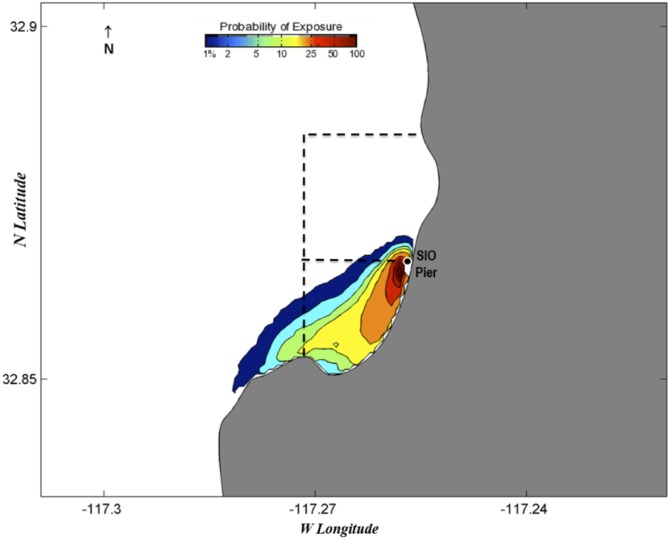
Probability map of predicted fish egg dispersal prior to collection: August 31-September 3, 2013.Dotted lines depict the boundaries of the MPAs: the San Diego-Scripps SMCA to the north and the Matlahuayl SMR to the south.